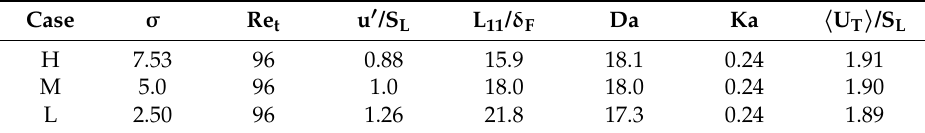
Table 1. Studied cases. H–high, M–medium, L–low.